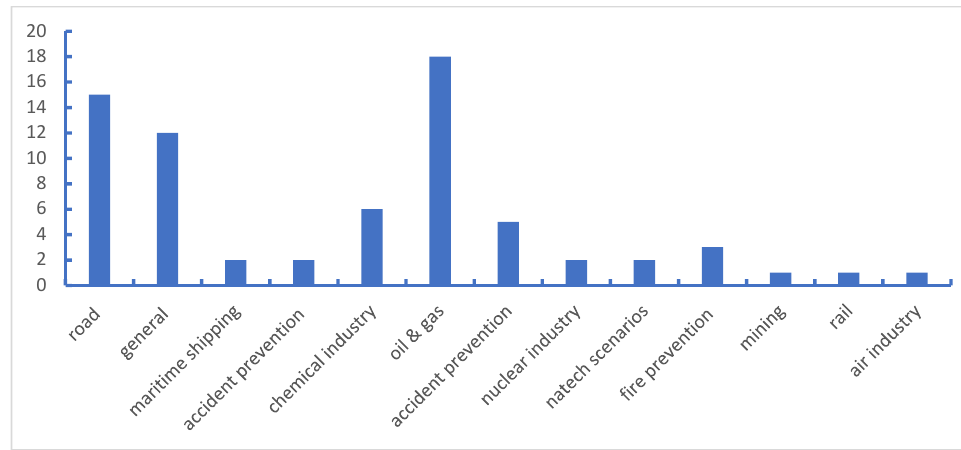
Figure 3. Distribution of the articles involved in the database.